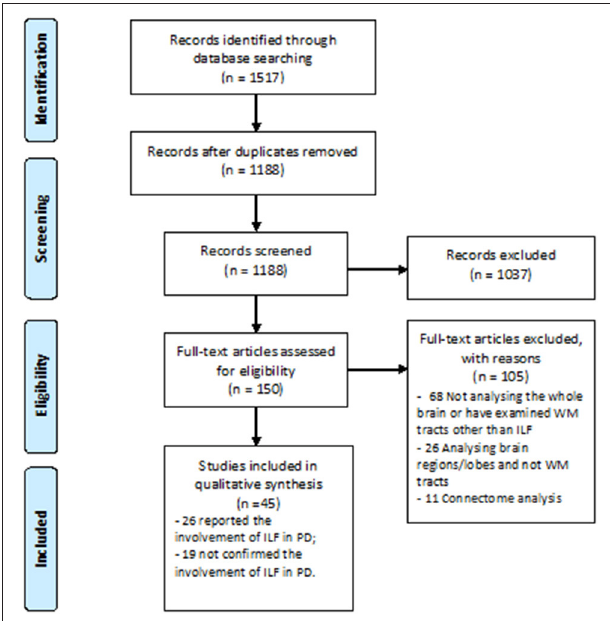
FIGURE 1 | PRISMA Flow Diagram of study